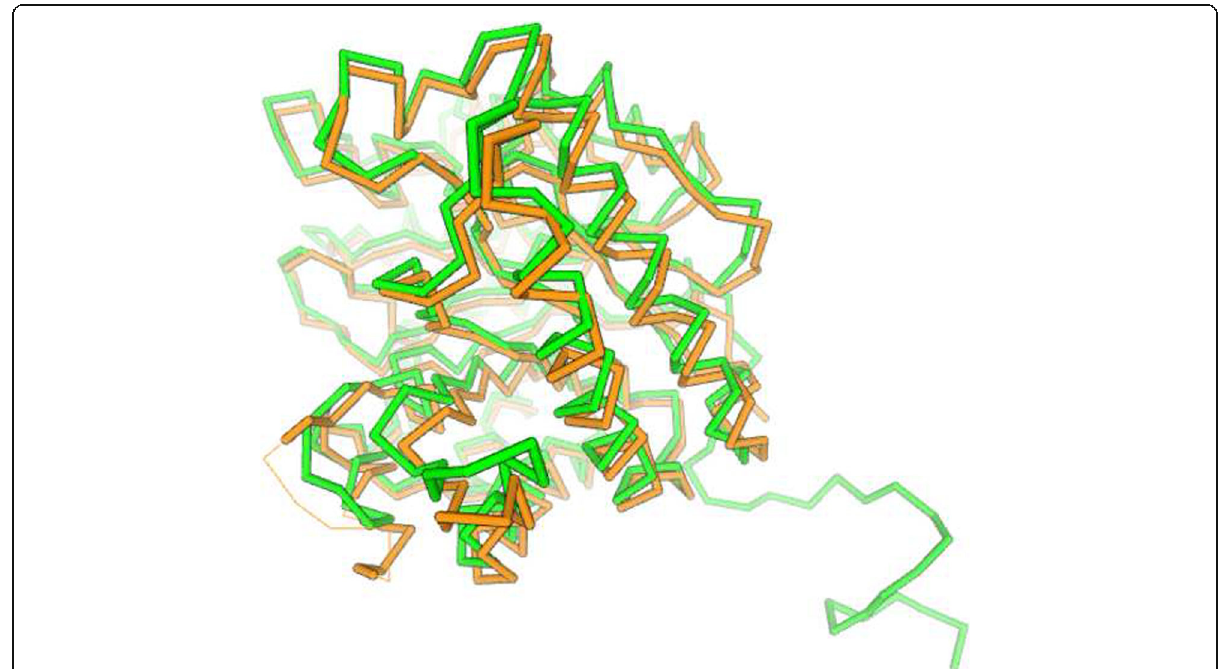
Fig. 5 Dali 3D structure alignment between query sequence P23660 (green) and template 6Q1I